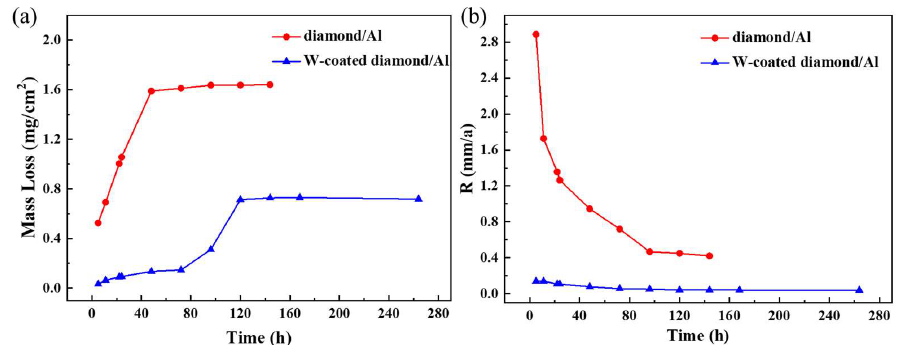
Figure 4. ( a ) Corrosion weight loss-time curve and ( b ) Corrosion rate-time curve of diamond/aluminum composite.